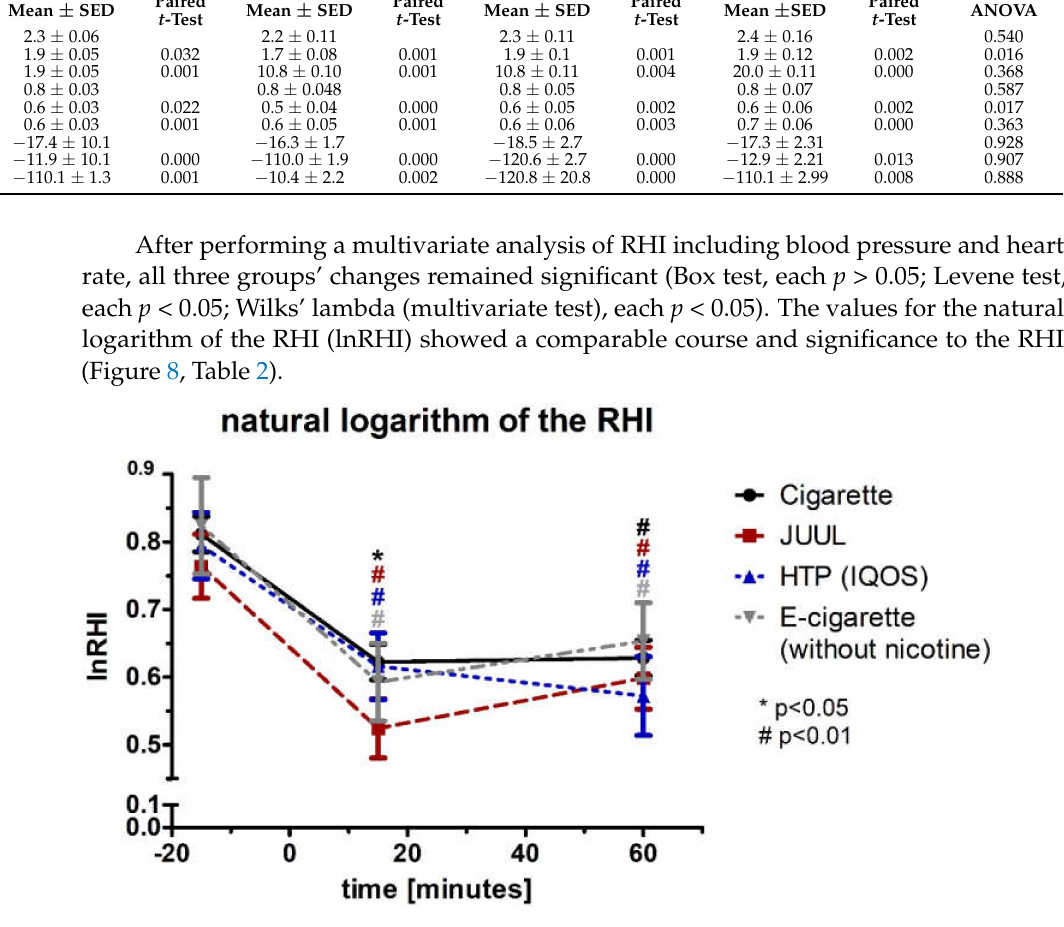
Figure 8. Natural logarithm of the RHI before and 15 as well as 60 min after consuming the cigarette, JUUL TM , heated tobacco product, and e-cigarette without nicotine. The augmentation index adjusted for a heart rate of 75 bpm (AI@75bpm; normal distributed) increased significantly in the groups of cigarette (+32%; p < 0.01),